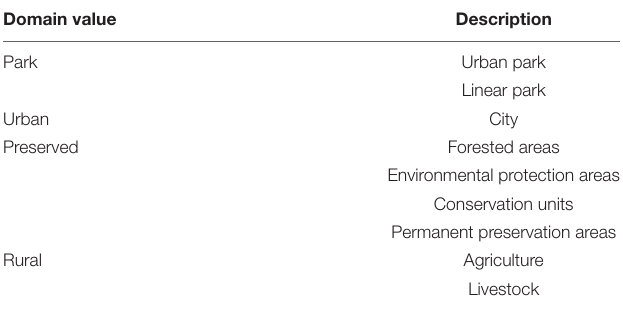
TABLE 2 | Description of the domains of the Name attribute of the AreaType